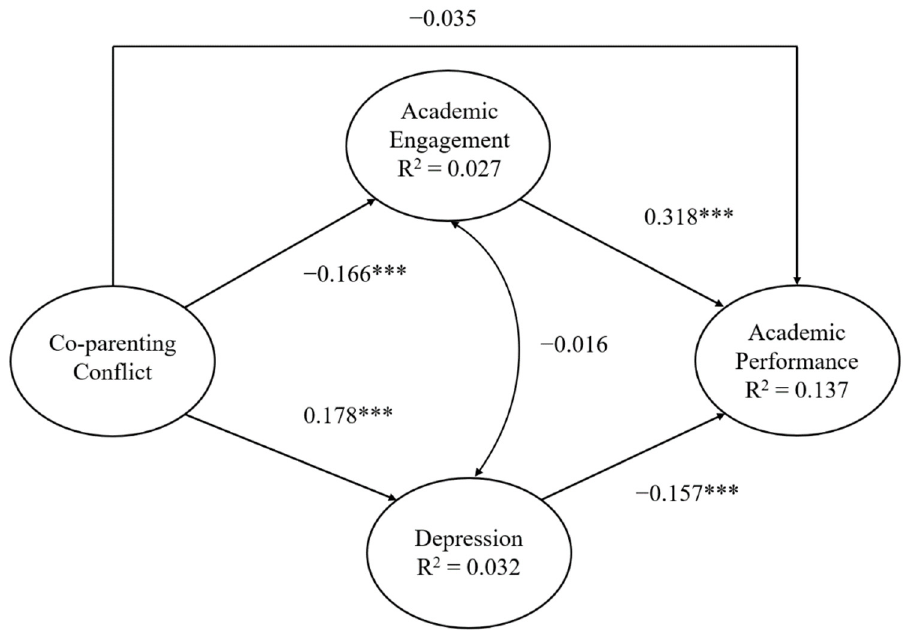
Figure 2. Structural equation model of direct and indirect effects on academic performance for Chinese 10–15-year-old adolescents. *** p < 0.001.